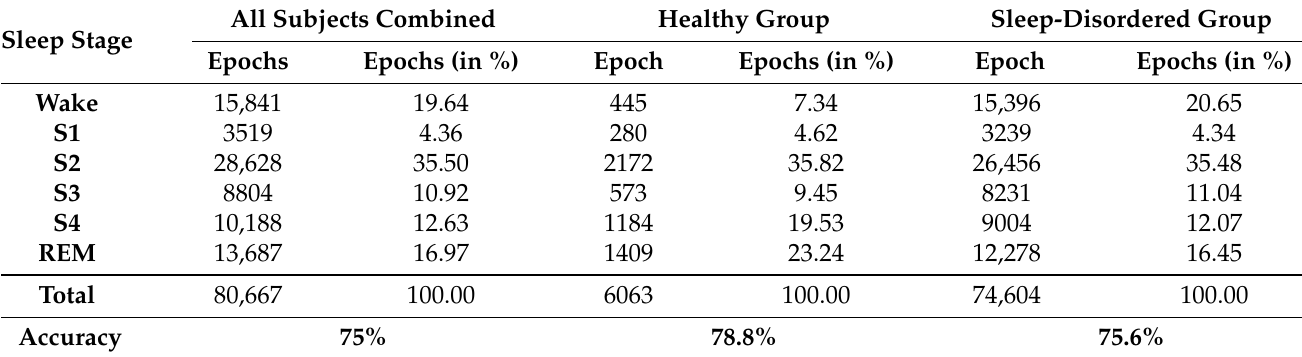
Table 29. Sleep stage-wise epochs and accuracy (before balancing) using the EBT classifier with 10-fold CV. Sleep